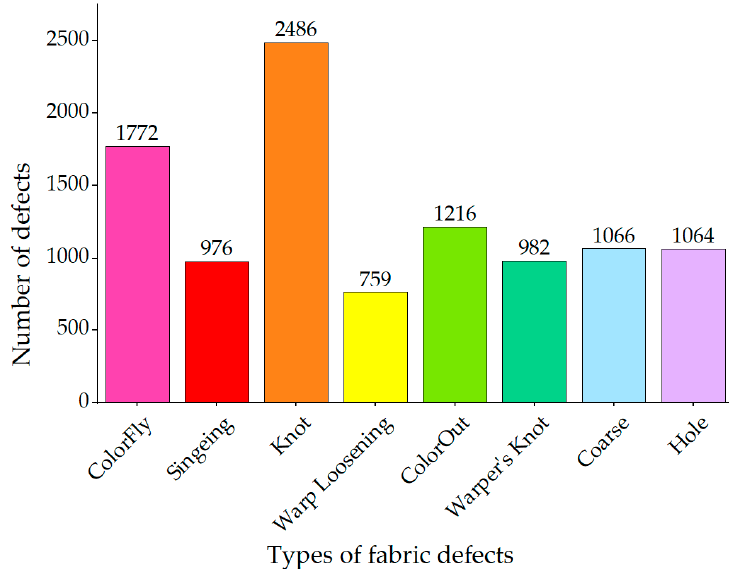
Figure 8. Statistics of fabric defect types.